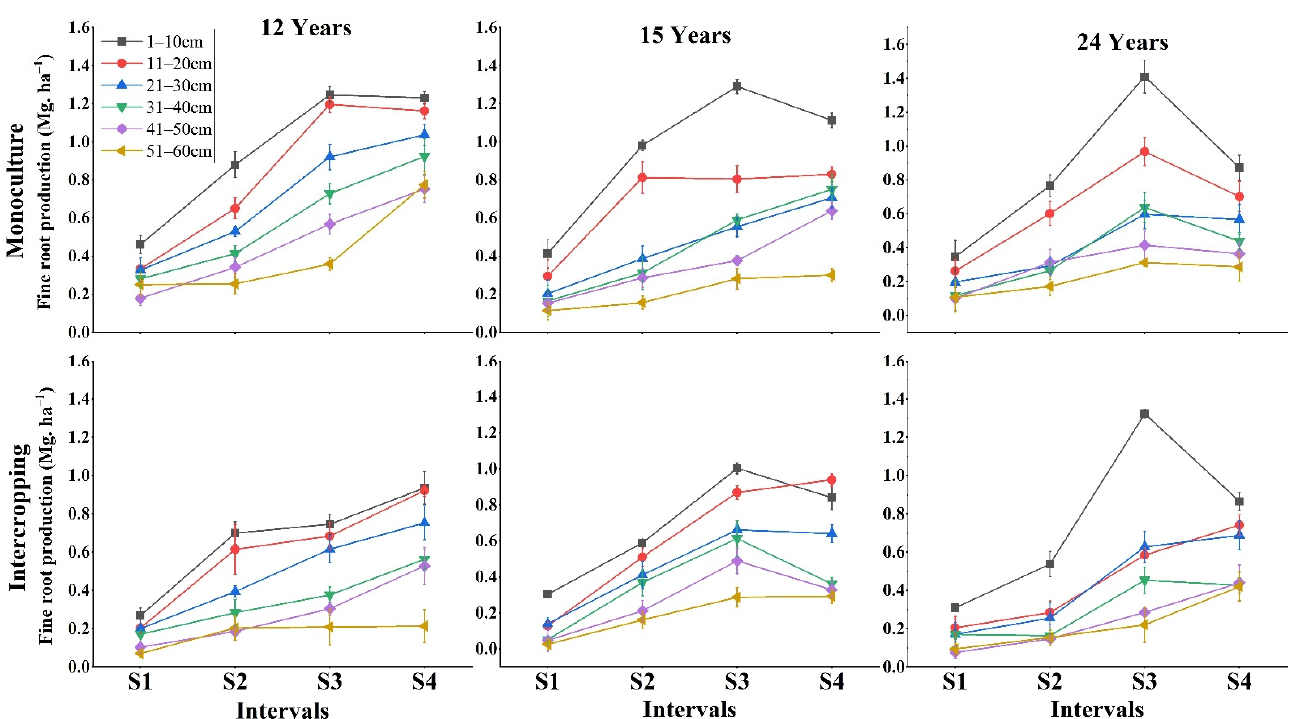
Figure 1. Fine root production in different soil layers across four sampling intervals (S1, June 2018; S2, September 2018; S3, December 2018; S4, March 2019) within different-aged stands of two plantation management types (rubber monoculture versus rubber–F. macrophylla intercropping).